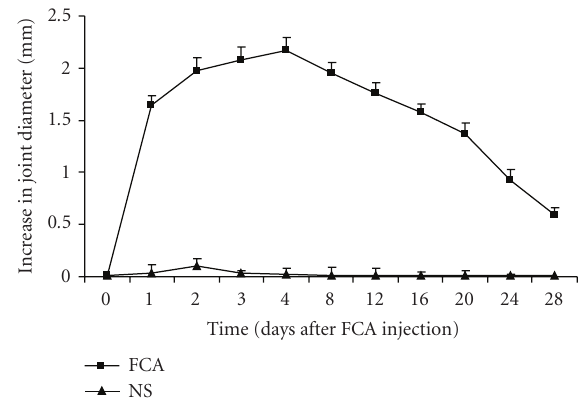
Figure 1: Time course for increase in joint diameter in FCA- induced monoarthritis in rats. Values are mean ± SEM.